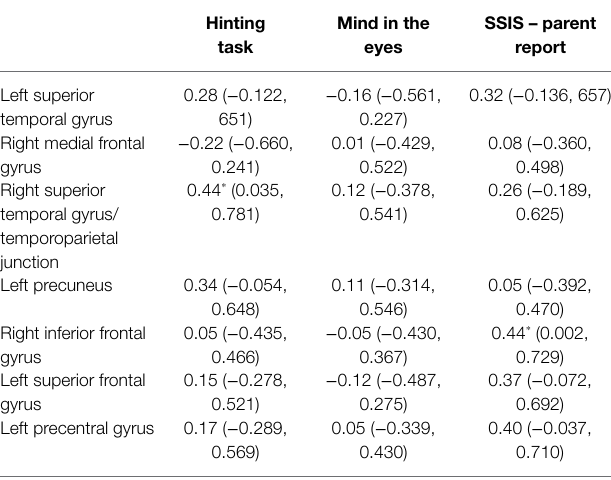
TABLE 2 | Correlations of regions of interest and social